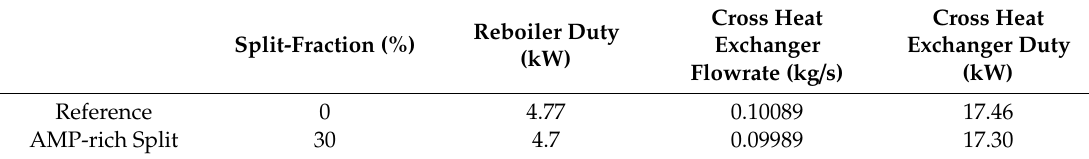
Table 5. Results for rich split